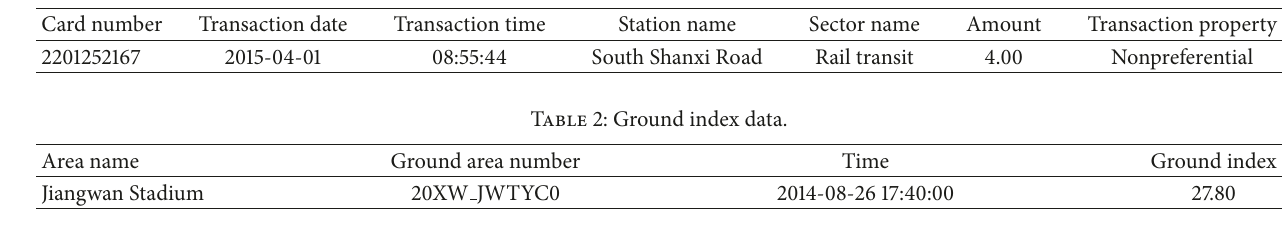
Table 1: IC card swipe data.